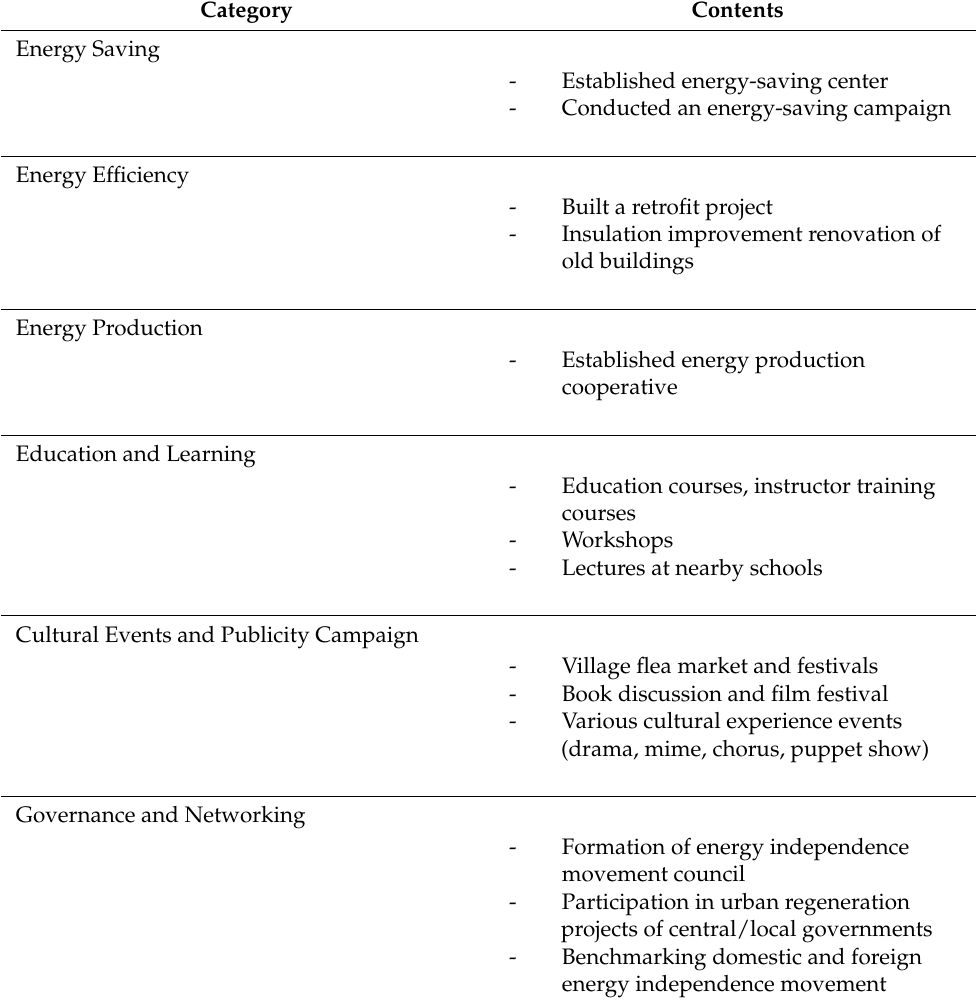
Table 1. Categories of Activities of